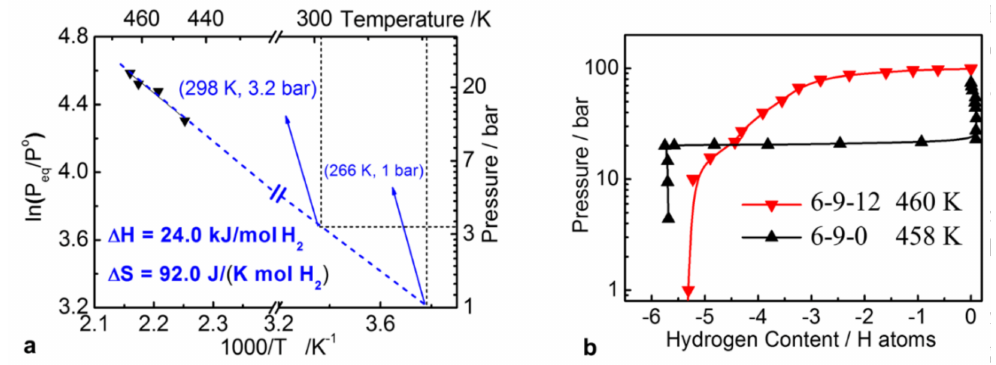
Figure 5. ( a ) van’t Hoff plot of 6Mg(NH 2 ) 2 + 9LiH + 12LiBH 4 ; ( b ) PCI curves for 6Mg(NH 2 ) 2 + 9LiH + 12LiBH 4 and 6Mg(NH 2 ) 2 + 9LiH at ca. 460 K